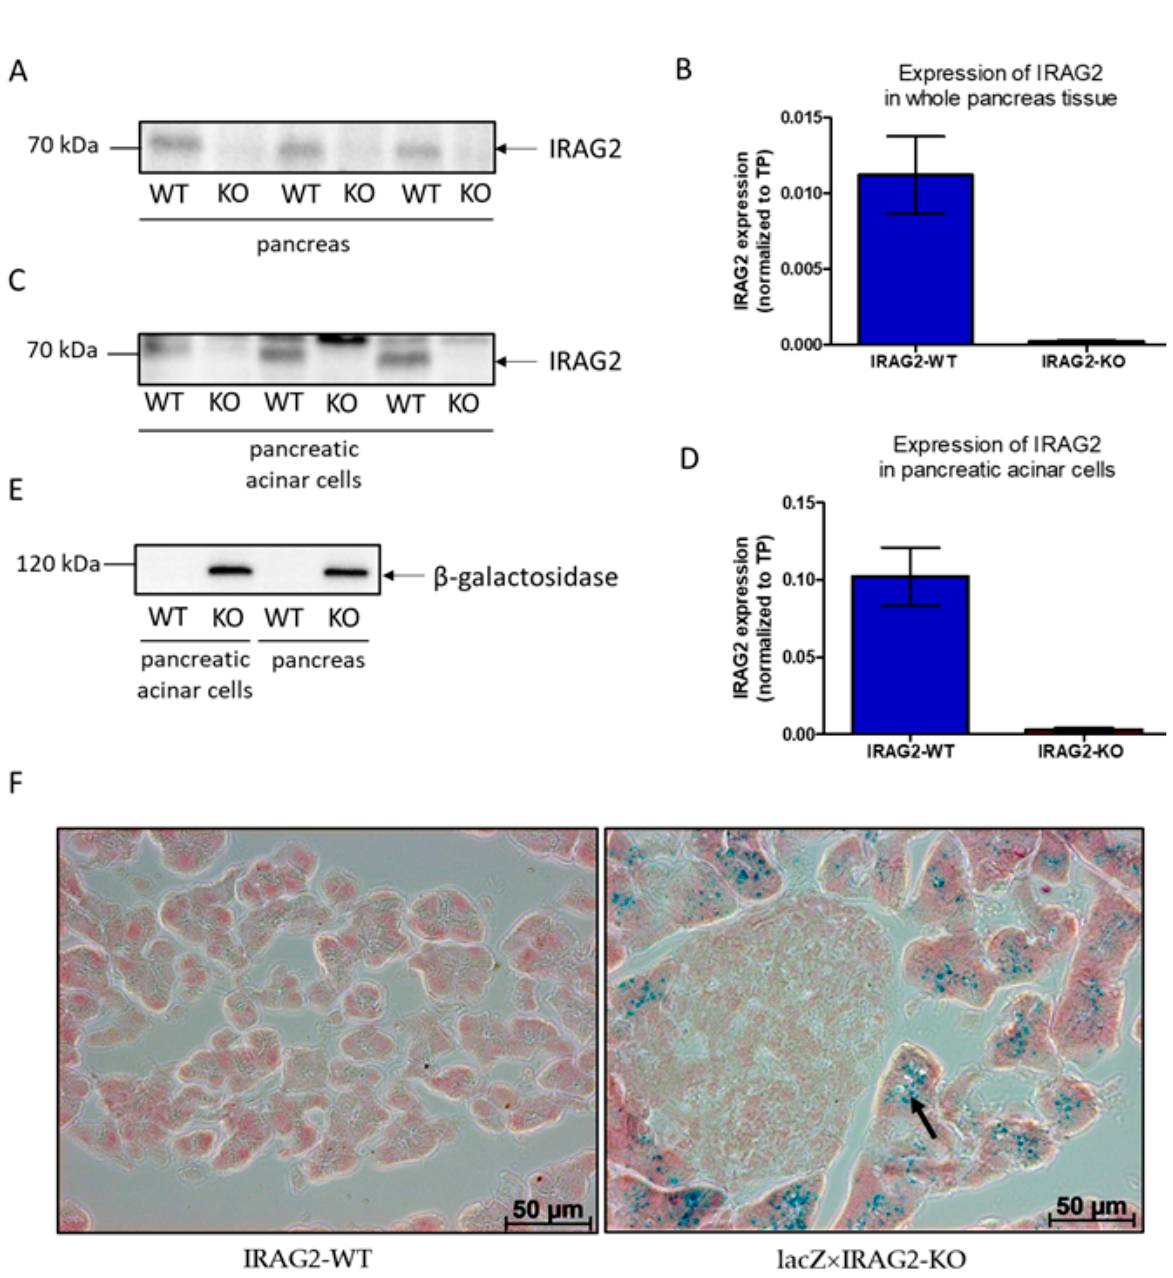
Figure 1. Expression and localization of IRAG2 in the murine pancreas. ( A,C ) Western blot analysis showed expression of IRAG2 protein in whole pancreas tissue ( A ) and isolated pancreatic acinar cells ( C ) of IRAG2-WT mice (WT), but no protein was detected in IRAG2-KO mice (KO). ( B ) IRAG2 expression in whole pancreas tissue of IRAG2-WT and IRAG2-KO mice normalized to total protein (TP) (WT: n = 12; KO: n = 12). ( D ) IRAG2 expression in pancreatic acinar cells of IRAG2-WT and IRAG2-KO mice normalized to total protein (TP) (WT: n = 6; KO: n = 6). ( E ) Western blot analysis indicated expression of β -galactosidase as a reporter for IRAG2 in whole pancreas and isolated pancreatic acinar cells of lacZ × IRAG2-KO mice (KO) but not in IRAG2-WT mice (WT). ( F ) Localization of β -galactosidase by X-Gal staining on pancreas cryosections from lacZ × IRAG2-KO and IRAG2-WT mice. Expression was detected in pancreatic acinar cells (indicated by arrow) but not in islets of Langerhans from lacZ × IRAG2-KO pancreata. No expression of β -galactosidase was detected in IRAG2-WT pancreata. In the graphs, mean ± SEM are shown. Images of total protein (TP) are shown in Figure S4. As IRAG2 has been previously described as a homolog of IRAG1 [8–10], we inves- tigated if IRAG1 is also expressed in whole pancreas tissue or pancreatic acinar